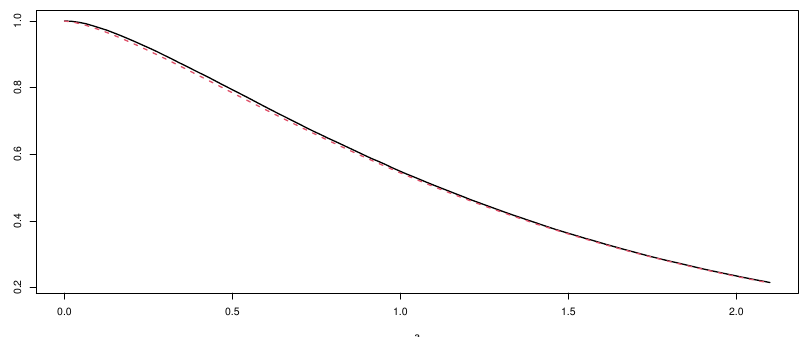
Figure 1. Exact and approximate tail probabilities for the empirical spatio-temporal estimator with n ( h , τ ) =